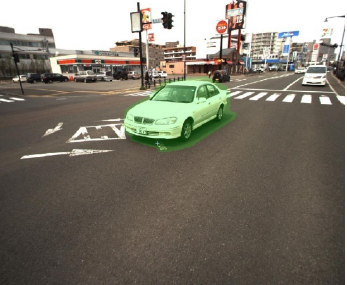
Figure 4. Example of image masking (coloured area by green)